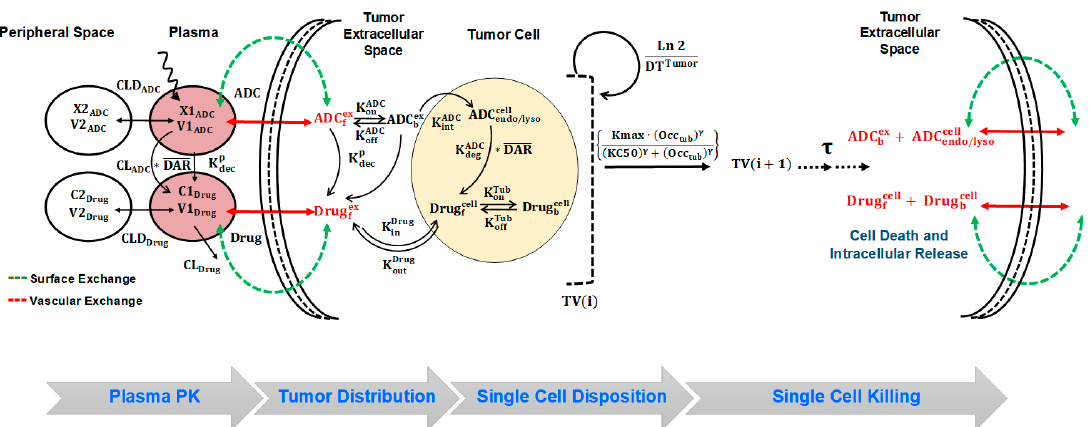
Figure 1. A schematic diagram of the systems pharmacokinetics-pharmacodynamics (PK-PD) model for antibody-drug conjugates (ADCs). Plasma PK: Disposition of Trastuzumab-Valine-Citrulline- Monomethyl Auristatin E (T-vc-MMAE) in systemic and peripheral spaces is characterized using a two-compartment model with linear clearance from the central compartment. Processes associated with non-specific shedding of MMAE and catabolic clearance of T-vc-MMAE contribute to the formation of unconjugated MMAE, which is also characterized using a two-compartment model with distribution to peripheral tissues and linear clearance from the central compartment. Tumor Distribution: the distribution of T-vc-MMAE and unconjugated MMAE was assumed to be driven from their central compartment to tumor extracellular space using two diffusive processes, i.e., surface and vascular exchange. Single Cell Disposition: once in the extracellular space, T-vc-MMAE was assumed to bind to HER2 receptors and internalize into the endosomal/lysosomal space of each cell. Upon enzymatic degradation and linker cleavage, unconjugated MMAE was assumed to release in the cytoplasmic space and either bind to intracellular tubulin or efflux out in the extracellular space. Single Cell Killing: occupancy of intracellular tubulin with MMAE drives the killing of cells and shuttles the growing cells into non-growing phases. Upon the death of each cell, the intracellular content becomes part of tumor extracellular space, which can distribute back into other cells or diffuse out in the systemic circulation.